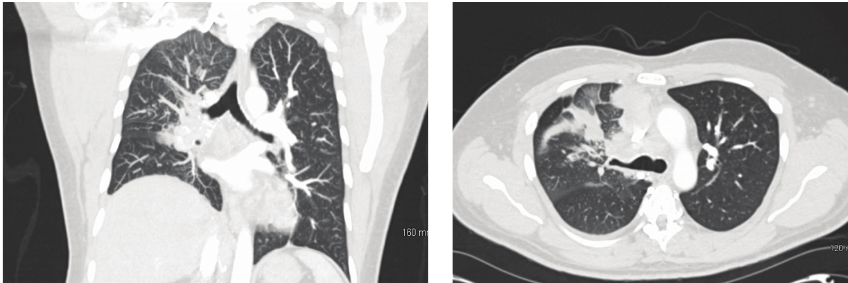
Figure 2: CT angiogram chest showing a large right mediastinal mass (8.8 × 6.2 × 9.6 cm), consistent with malignancy involving the right cardiac atrium with occlusion of the right main pulmonary artery which is either compressed or invaded by the mass, and nonopacification of right pulmonary arteries. No left pulmonary embolus is seen. Metastatic adenopathy in the mediastinum and probably right hilum. There are enlarged mediastinal lymph nodes, measuring up to 2.6 × 2.2 cm in the precarinal region and 2.2 × 1.9cm in the anterior superior mediastinum.